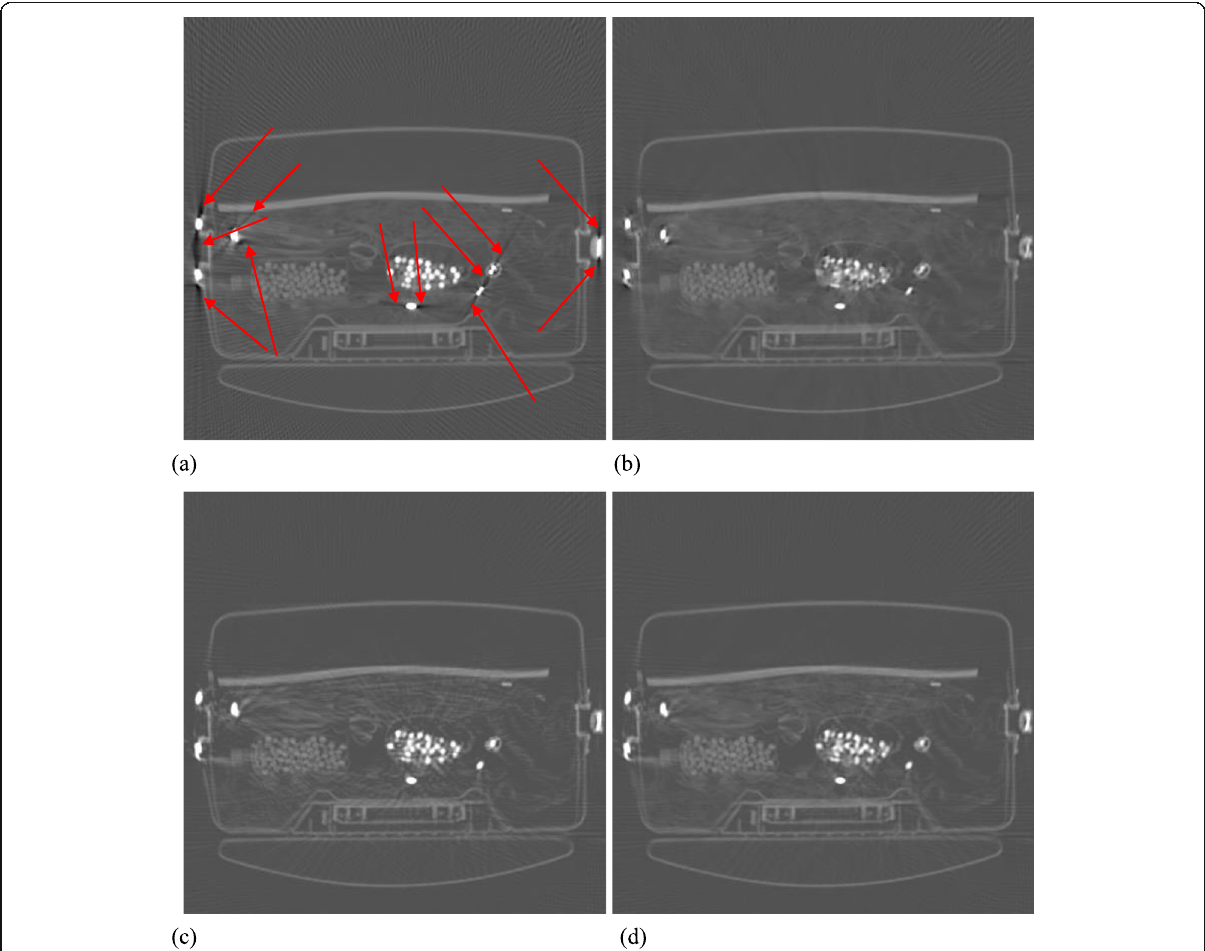
Fig. 4 Reconstruction of bag #4. a Raw FBP; b TV-term only; c Non-negativity-term only; d Combined. Some artifacts are marked by the red